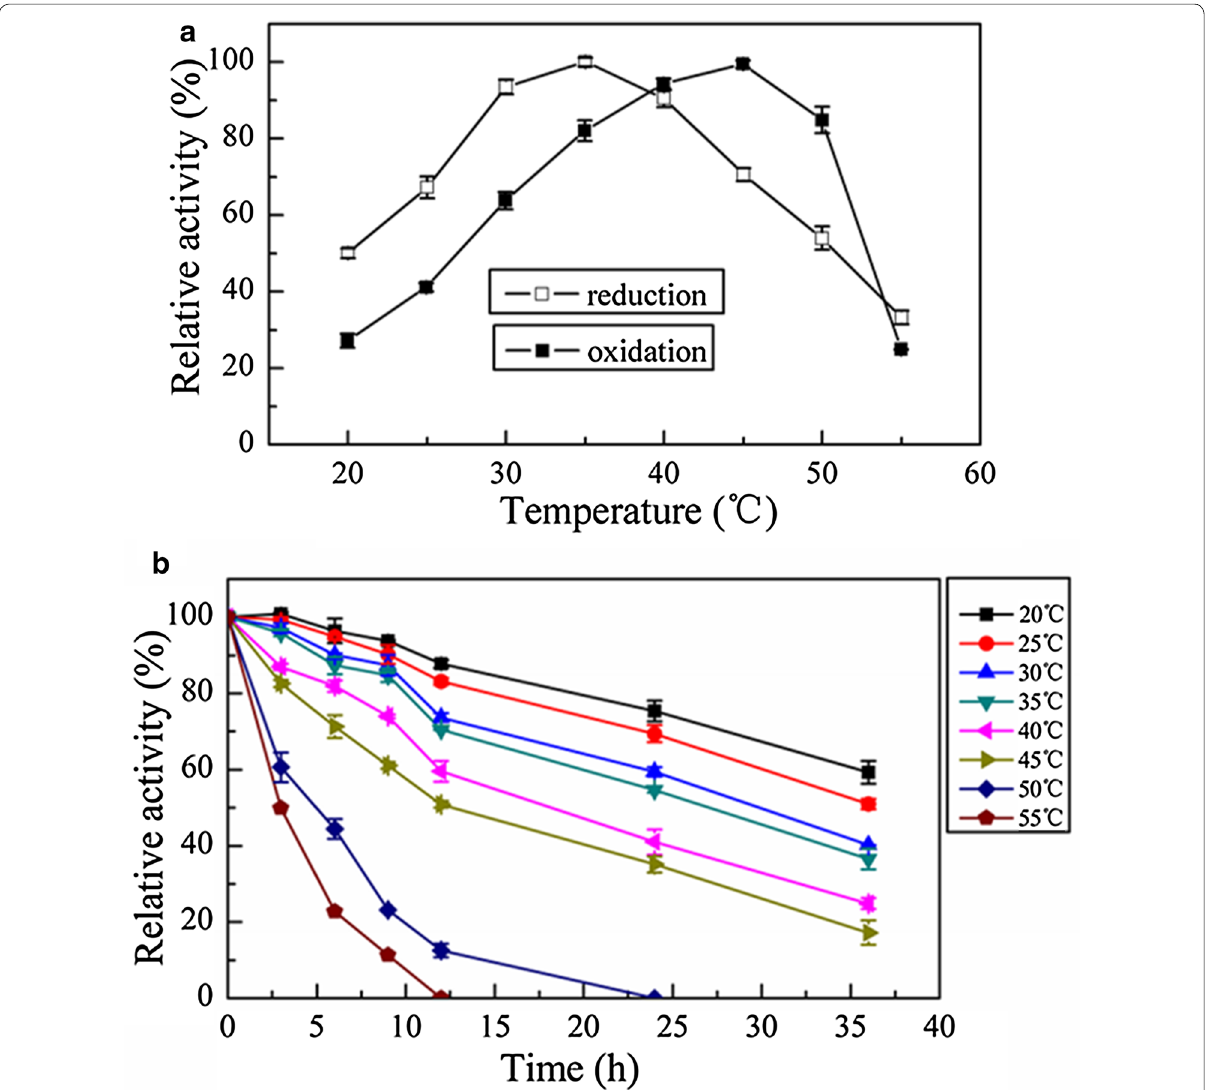
Fig. 4 Effects of temperature on the activity and stability of the recombinant AcCR. Reaction conditions: a 0.25 mM NADH or 0.5 mM NAD + , 2 mL 50 mM citrate–phosphate buffer (pH 6.5 or 8.0), and 5 mM 4 ′ ‑chloroacetophenone or 150 mM isopropanol were incubated at 20–55 °C for 5 min before adding 20 μL purified recombinant AcCR (about 0.008 mg of the purified enzyme), and the changes of absorbance for 3 min at 20–55 °C, respectively, were recorded; b 0.25 mM NADH, 2 mL 50 mM citrate–phosphate buffer (pH 6.5), and 5 mM 4 ′ ‑chloroacetophenone were incubated for 5 min at 35 °C, then added 20 μL purified recombinant AcCR (about 0.008 mg of the purified enzyme, incubated at 20–55 °C), and the changes of absorbance for 3 min were